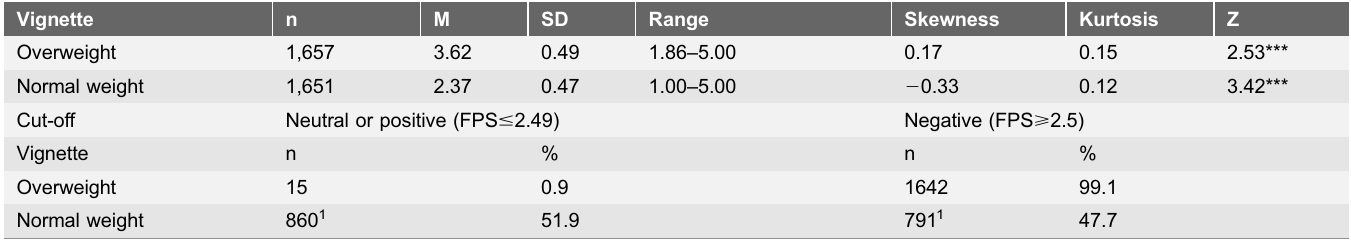
Table 2. Mean scores of Fat Phobia Scale (FPS) and distribution of FPS scores according to a cut-off indicating neutral/positive or negative attitudes towards overweight and obesity [14,22].